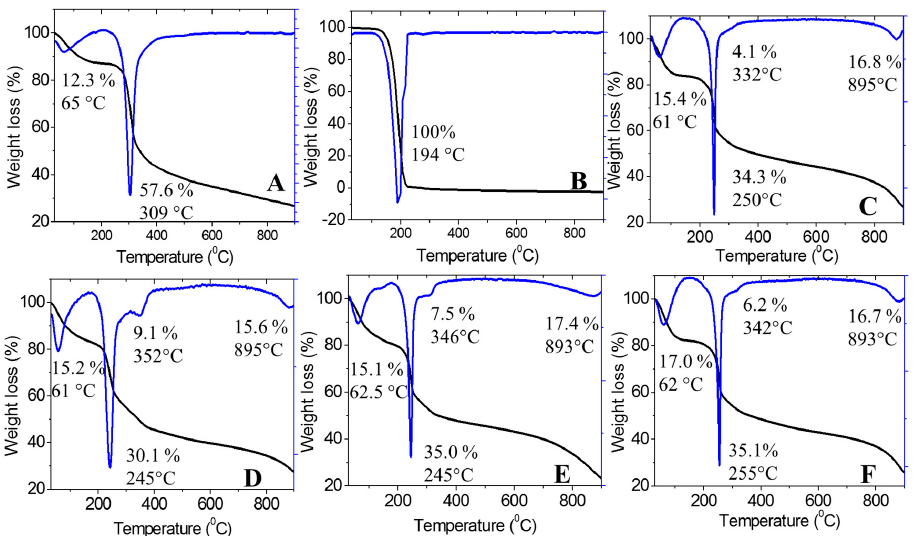
Figure 3. Thermogravimetric (black curve) and differential thermogravimetric (blue curve) (TGA/DTG) thermograms of ( A ) chitosan, ( B ) pure dazomet, and chitosan-dazomet nanoparticles prepared at various concentrations of TPP: ( C ) 2.5, ( D ) 5, ( E ) 10, and ( F ) 20 mg/mL.